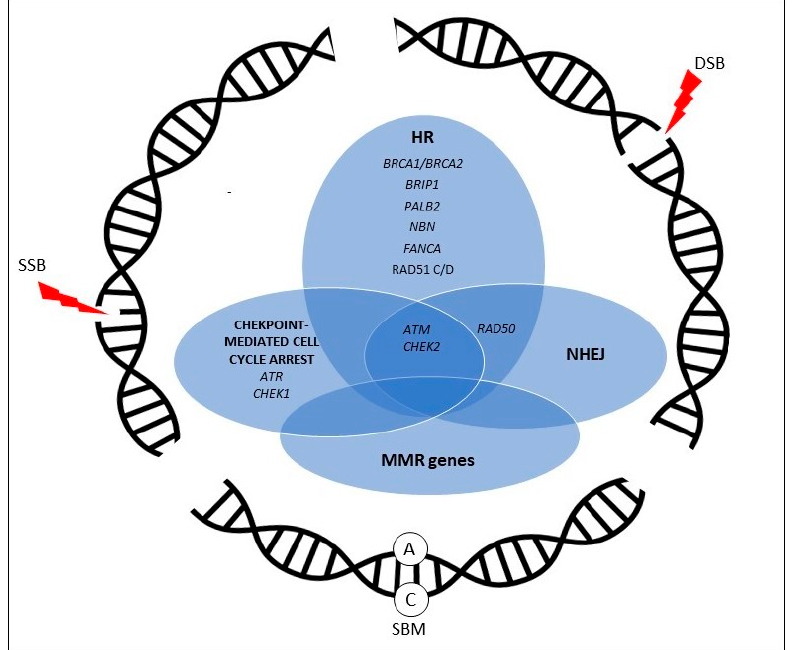
Figure 1. Overview of DNA damage response pathways with genes altered in both pancreatic and prostate cancer. HR = homologous recombination, NHEJ = nonhomologous end-joining, MMR = mismatch repair, SBM = single-base mismatch.